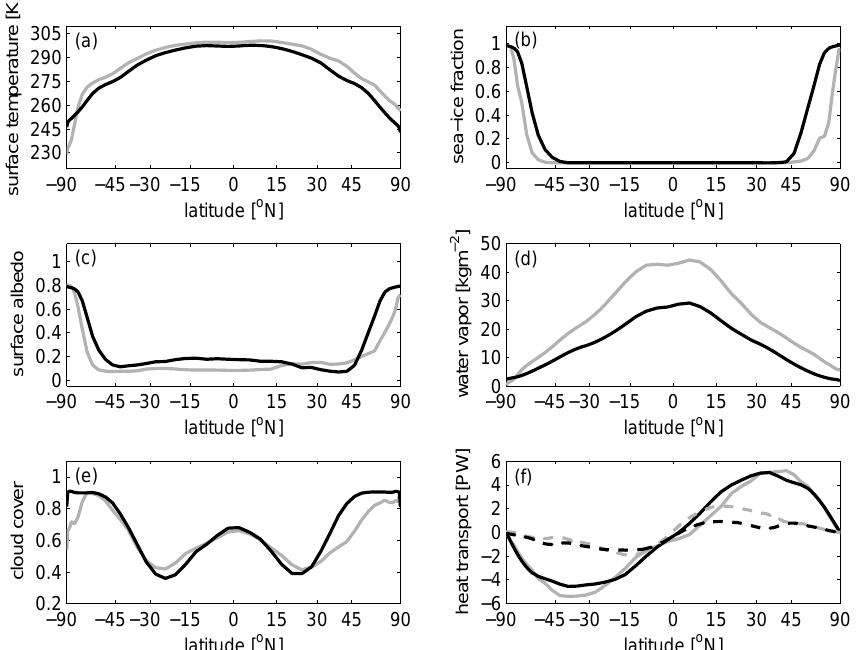
Fig. 3. Time and zonally averaged surface temperature (a) , (b) sea-ice fraction (only taking into account ocean points), (c) surface albedo, (d) vertically integrated water vapor, (e) cloud cover, and (f) atmosphere (solid) and ocean (dashed) heat transport in MAR (black) and PI (gray). The abscissae are linear in sine of latitude.